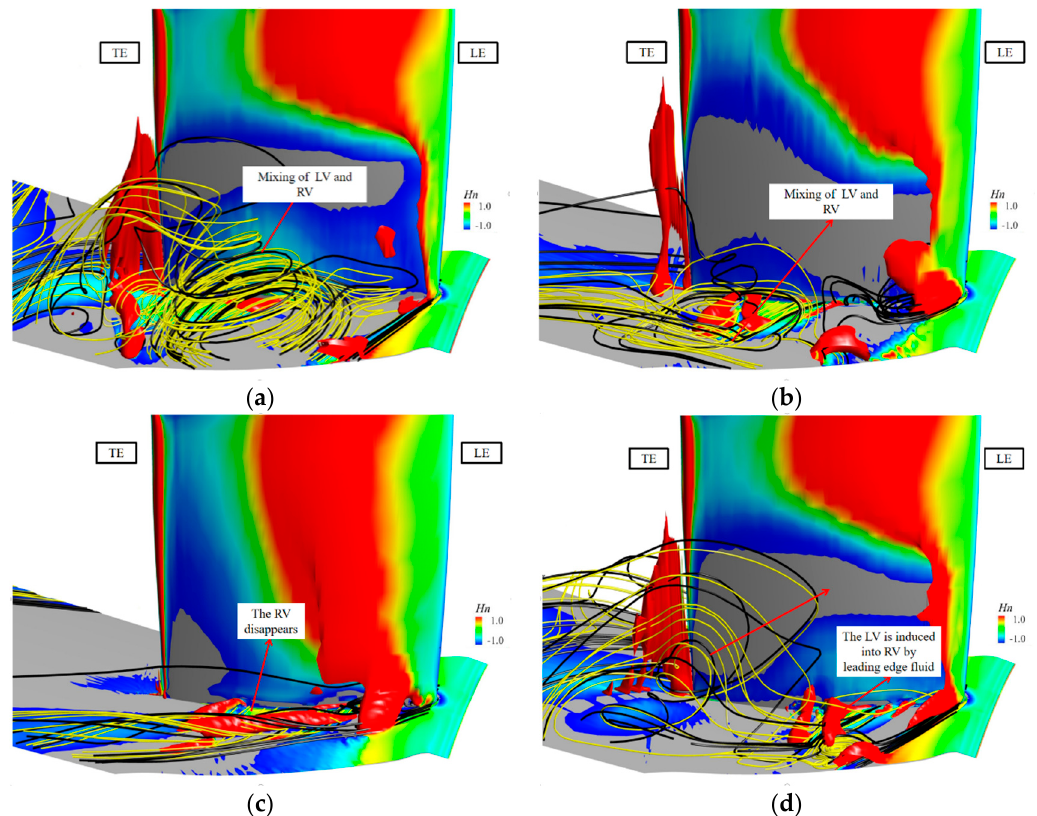
Figure 11. Three-dimensional clearance leakage and the radial streamlines (Q=50,000 s − 2 ). ( a ) Case 1; ( b ) Case 2; ( c ) Case 3; ( d ) Case 4.